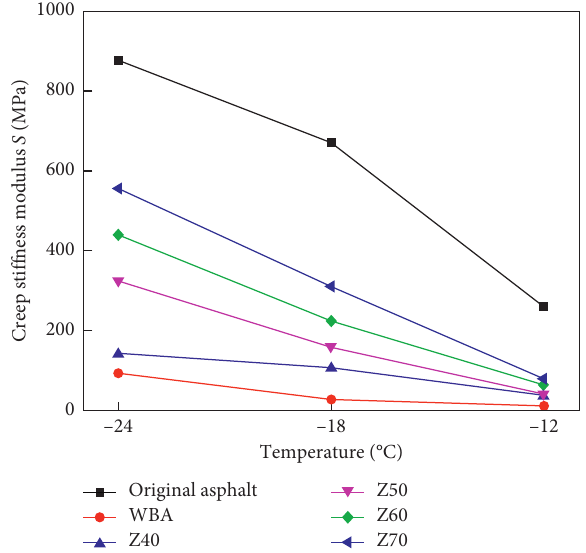
Figure 8: Creep stiffness modulus S at different temperatures.